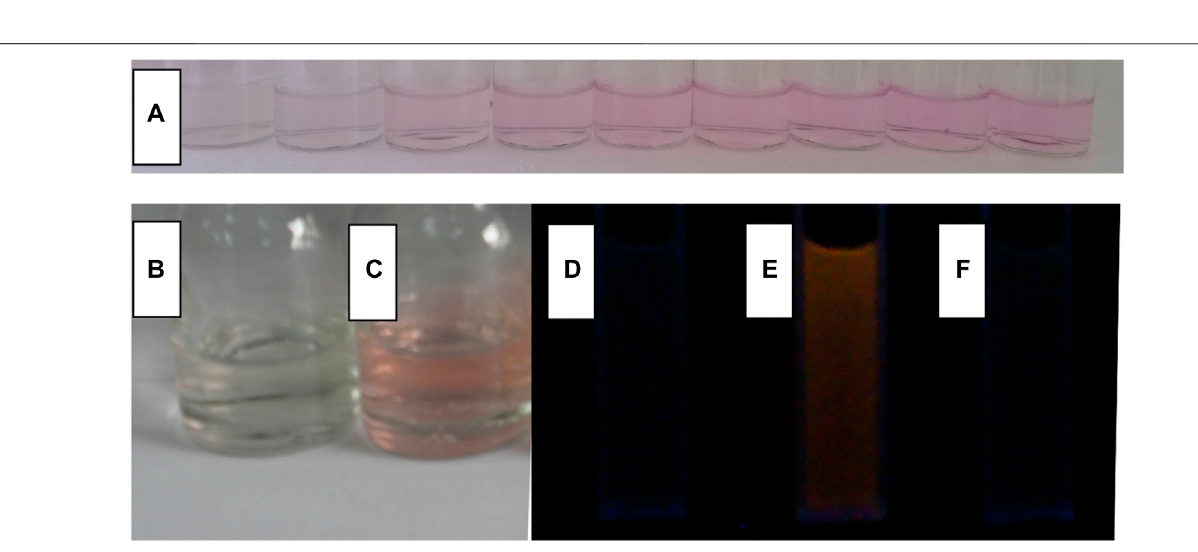
FIGURE 5 | In the aqueous (containing 5% ethanol as a co-solvent), (A) , a photo of CS2 (10 μ M) with the addition of Fe 3+ (from left to right, 0, 0.2, 0.5, 1, 2, 3, 4, 5 and 6 μ M); a photo of CS2 (10 μ M) without (B) and with (C) Fe 3+ (5.0 equiv), an emission photo of CS2 (10 μ M) without Fe 3+ (D) , with Fe 3+ [5.0 equiv, (E) ], and sequentially adding Fe 3+ and EDTA [5.0 equiv:5.0 equiv, (F)